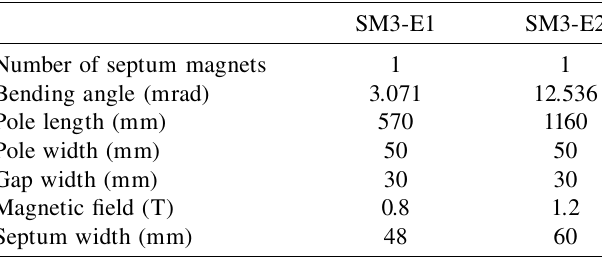
TABLE X. Parameters of septum magnets used to estimate the fast-extraction system of the HE-FFAG.